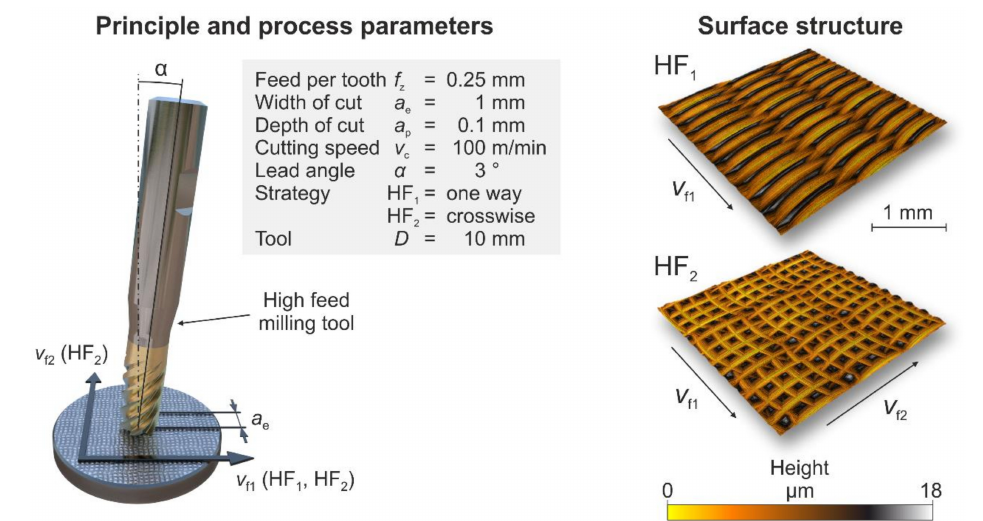
Figure 2. Process kinematics of high-feed structuring ( left ) and topography of surface structure of HF 1 and HF 2 ( right ).